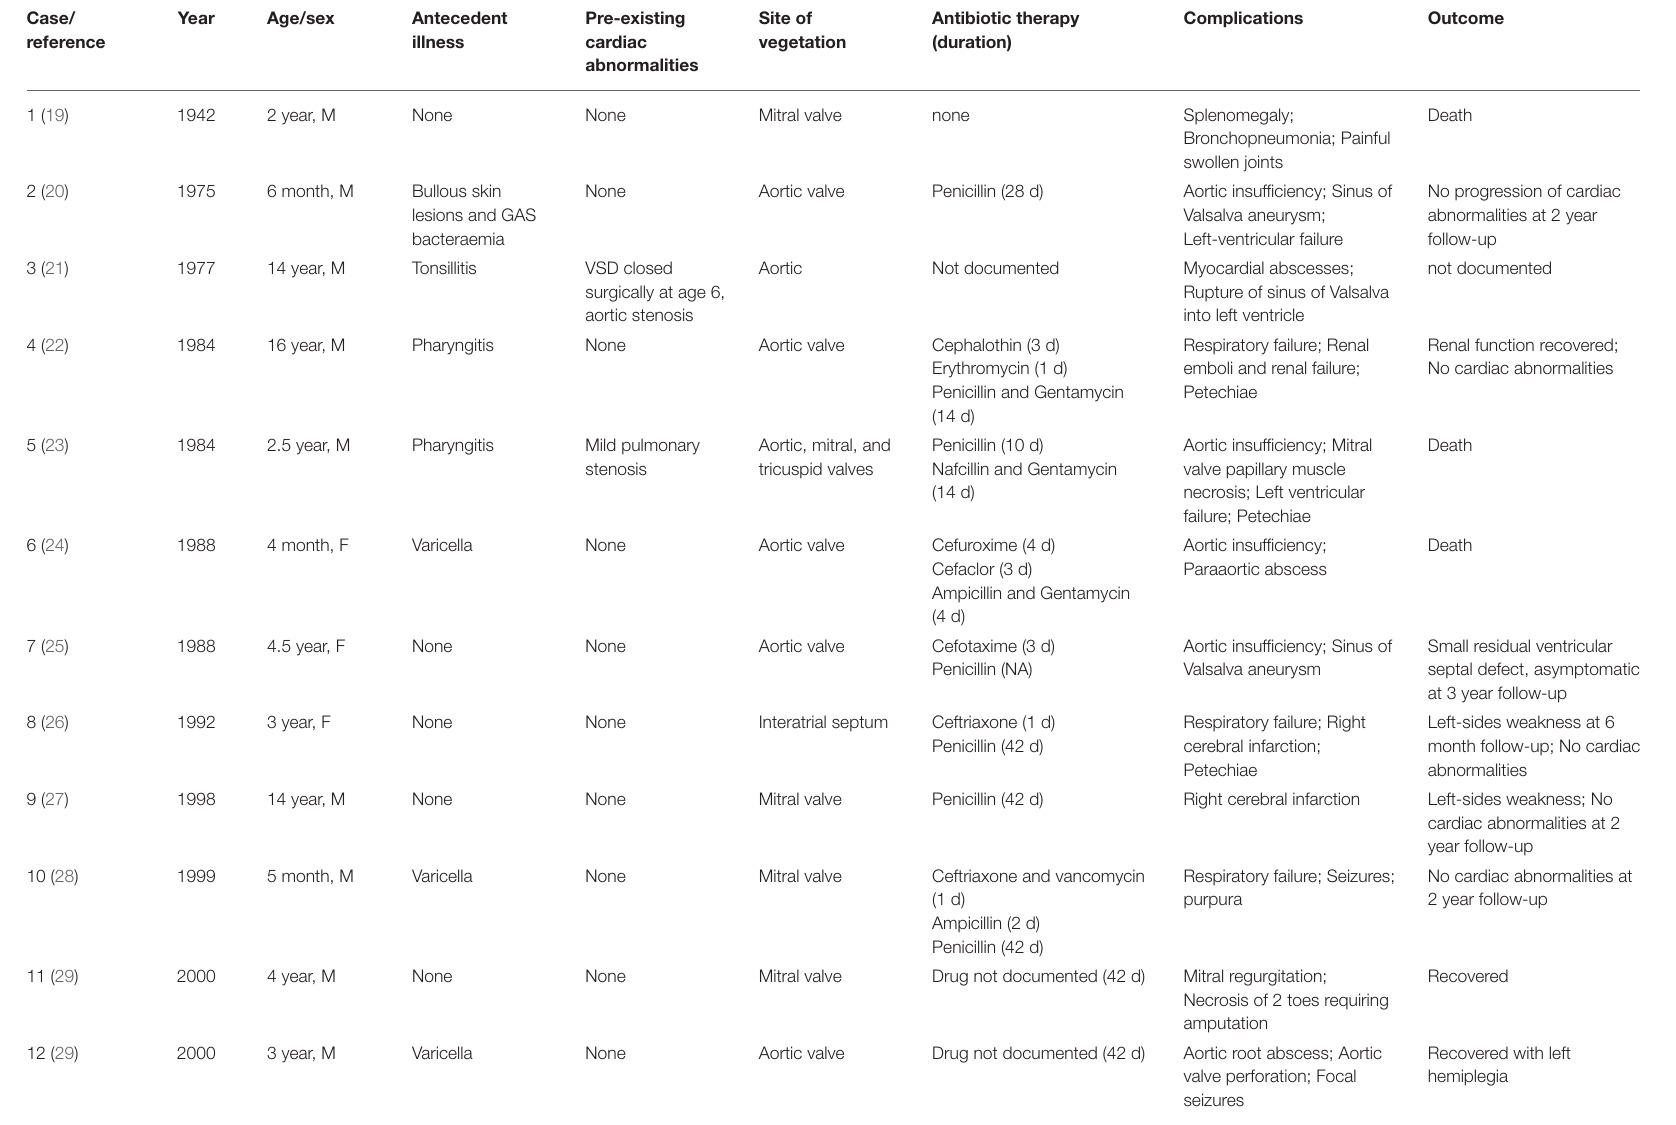
TABLE 1 | Summary of pediatric cases of IE due to GAS as reported since 1942. Case/